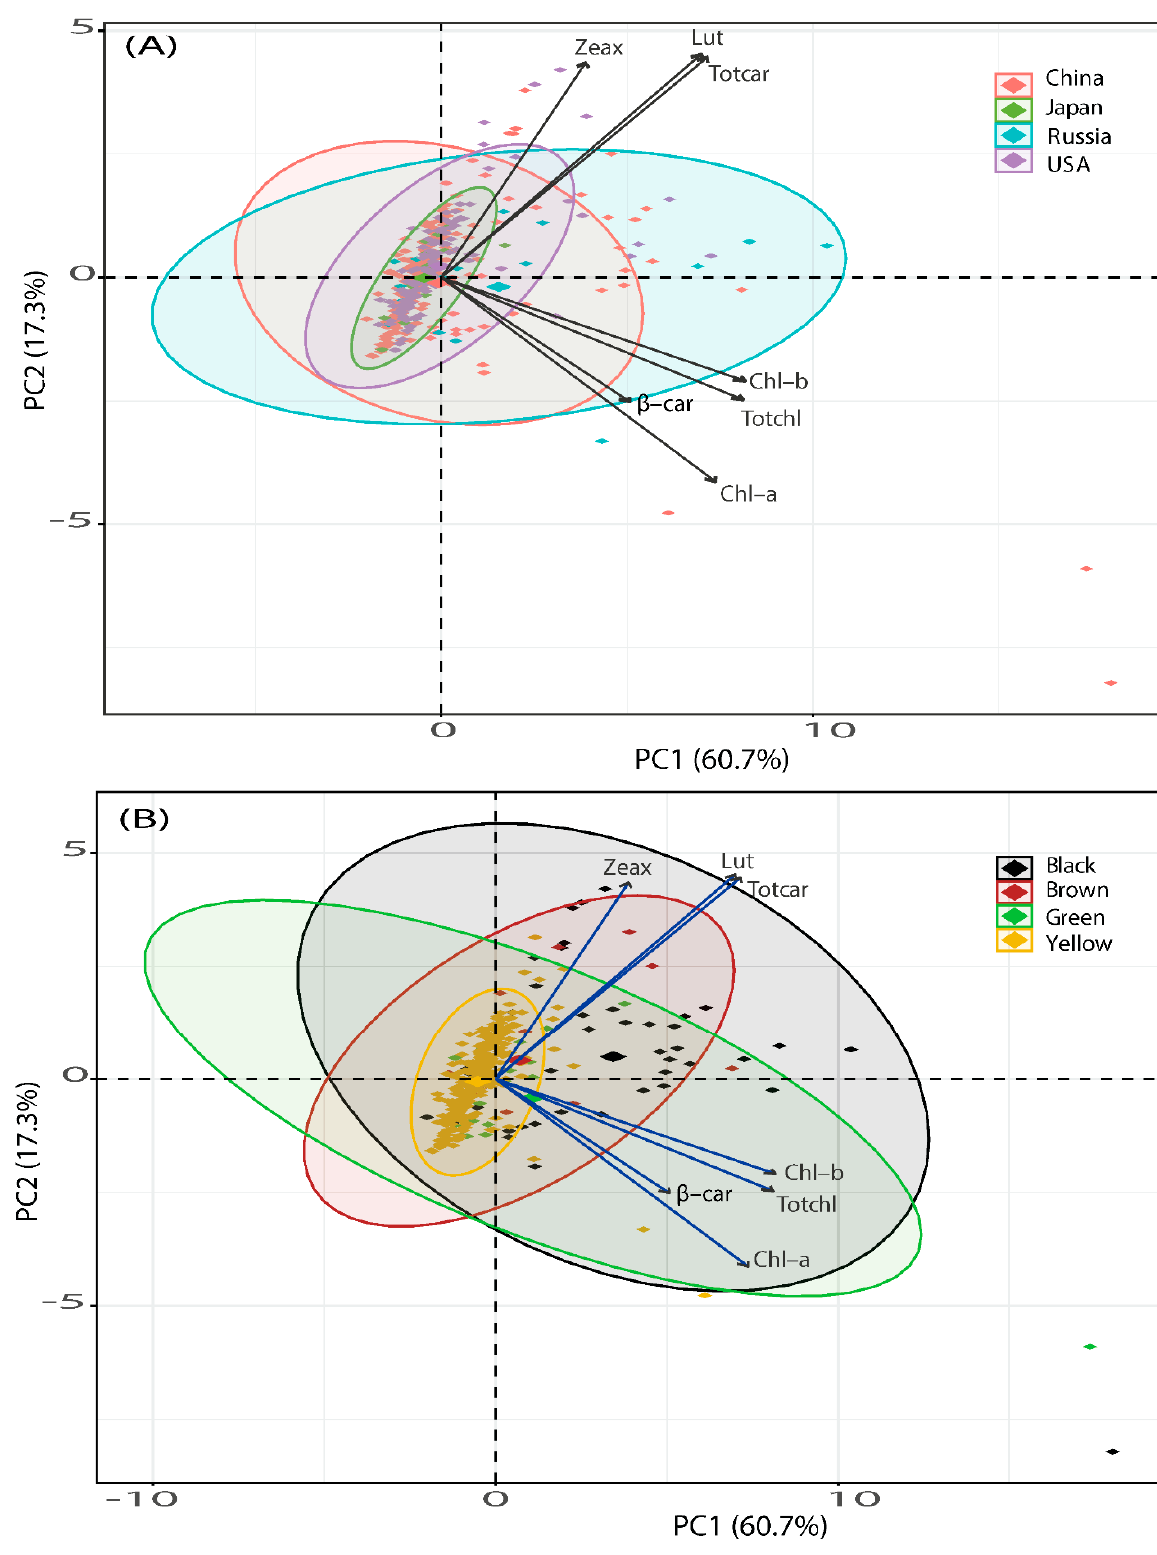
Figure 4. Principal component analysis (PCA) on carotenoid and chlorophyll components of world soybean accessions based on ( A ) country of origins; ( B ) seed coat colors. Each of the points on the biplots with different colors and symbols represents a single soybean accession signifying origin and seed coat color. Lut, lutein; Zeax, zeaxanthin; β -car, β -carotene; Totcar, total carotenoids; Chl-a, chlorophyll-a; Chl-b, chlorophyll-b; Totchl, total chlorophylls.